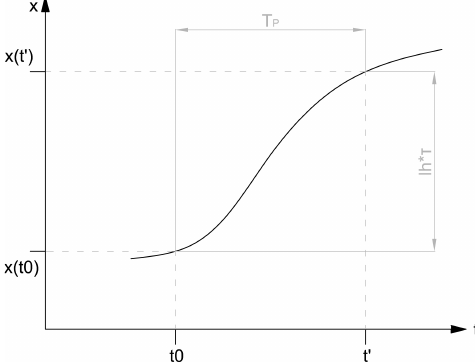
Figure 13. Time of the traction phase.